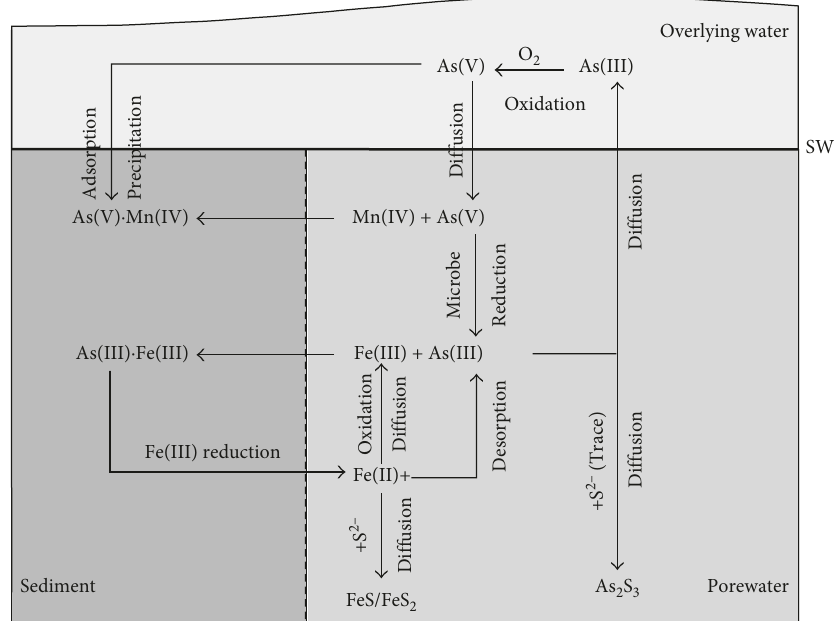
Figure 7: Transportation and transformation of arsenic at the intertidal SWI of Bohai